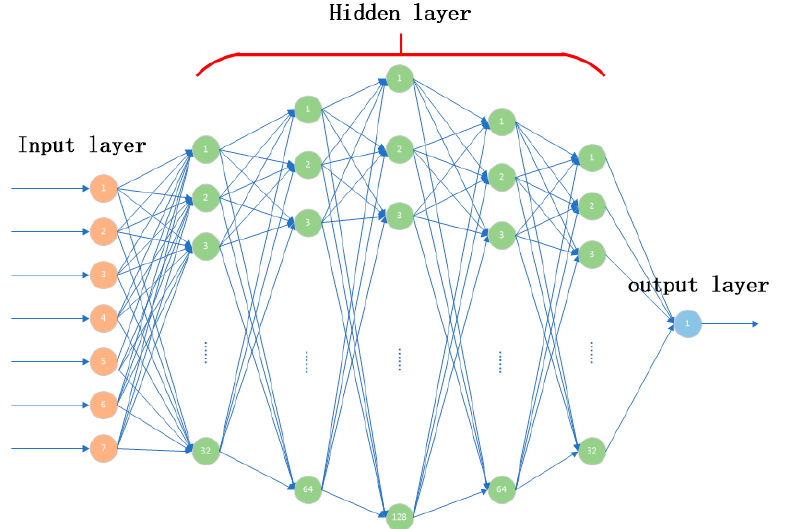
Figure 3. The volume prediction model structure of fully connected neural network.